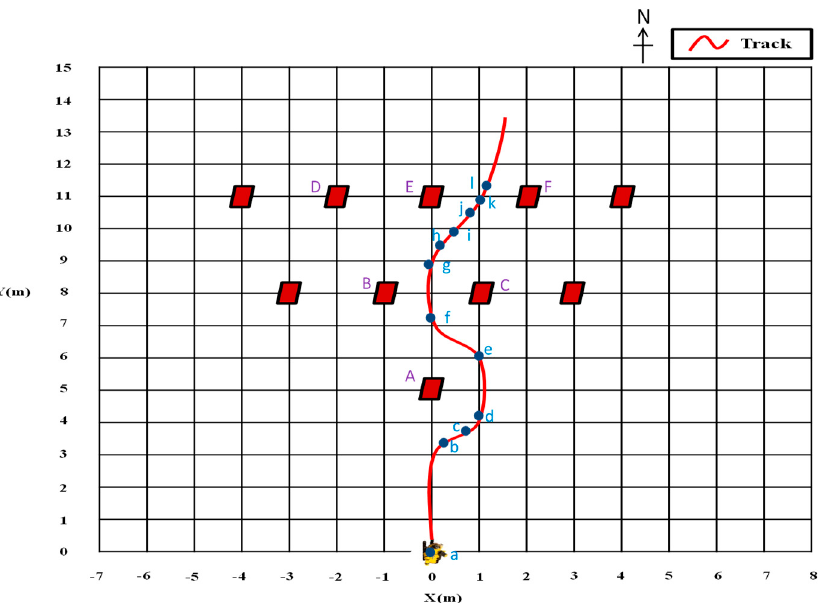
Figure 12. Trajectory of the obstacle avoidance of the ROV. The obstacles are identified by purple upper-case letters. The points of the scan map are marked by blue lower-case letters. The red line signifies the trajectory of the ROV.